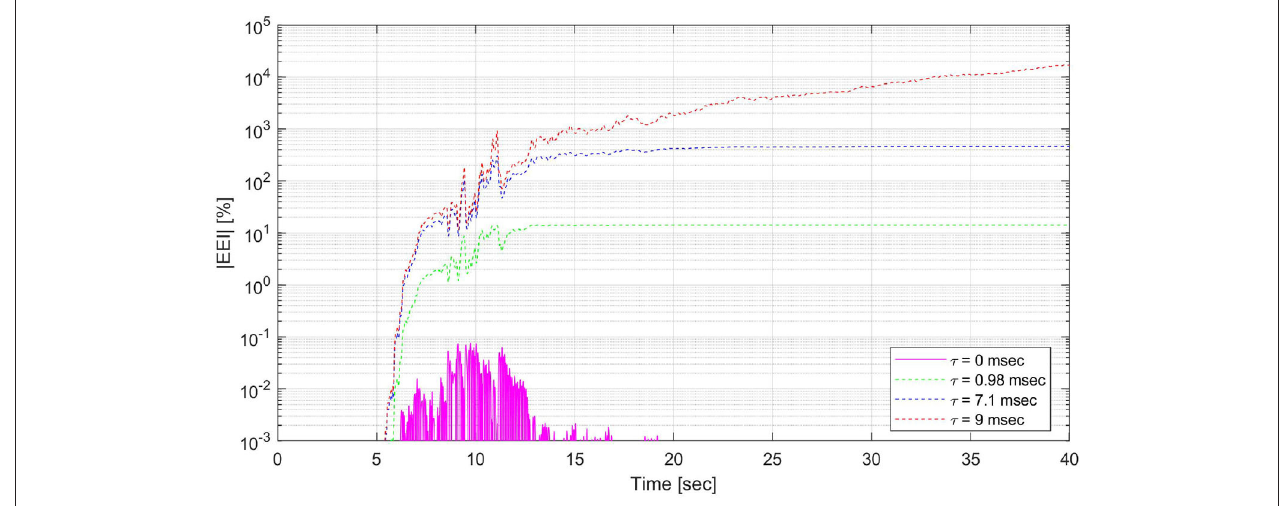
FIGURE 8 | Energy error indicator ( EEI ) for different delay values.